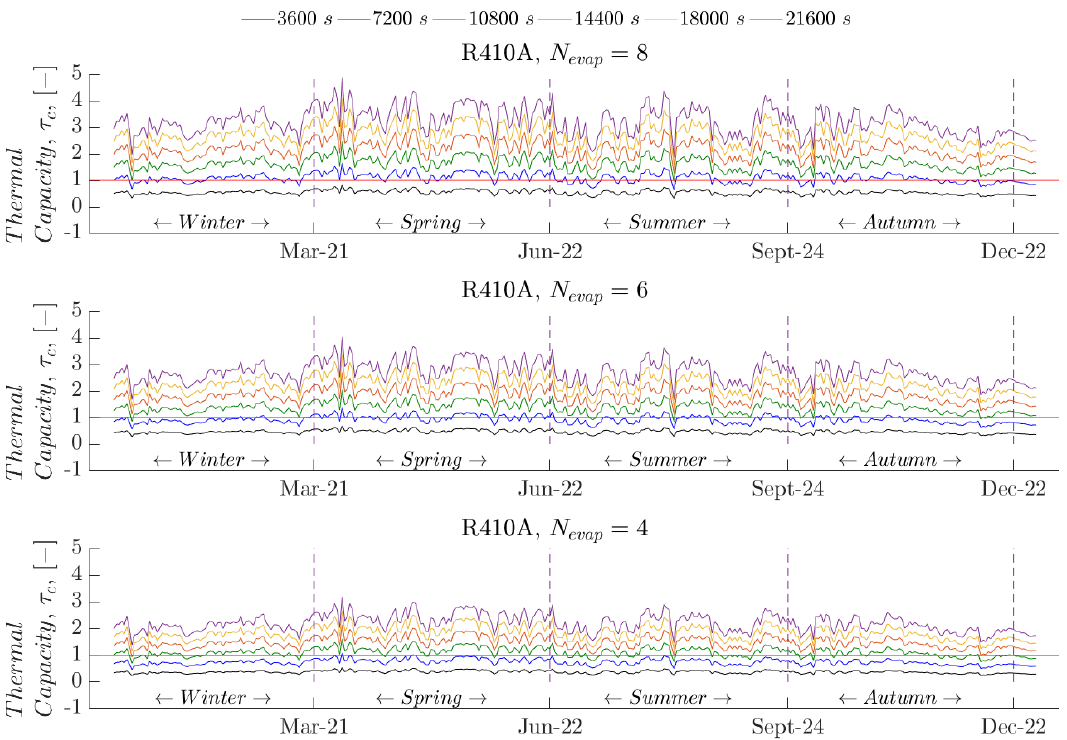
Figure 6. Thermal capacity of the heat pump during the year using R410A as working fluid.